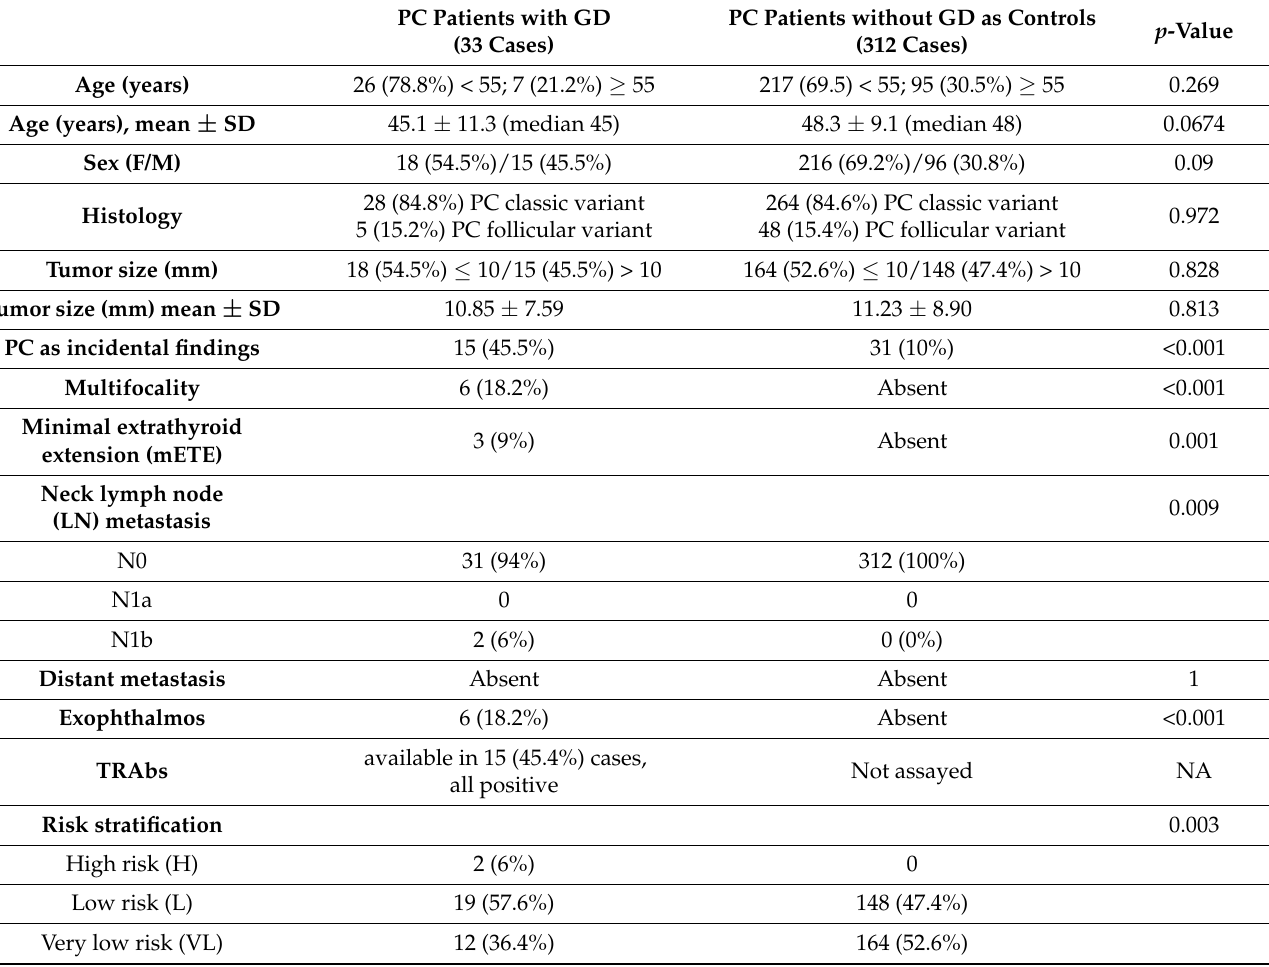
Table 1. Demographic and histological characteristics of 33 patients with papillary carcinoma (PC) and associated Graves’ disease (GD), and 312 patients with PC without GD as controls at the surgery of primary